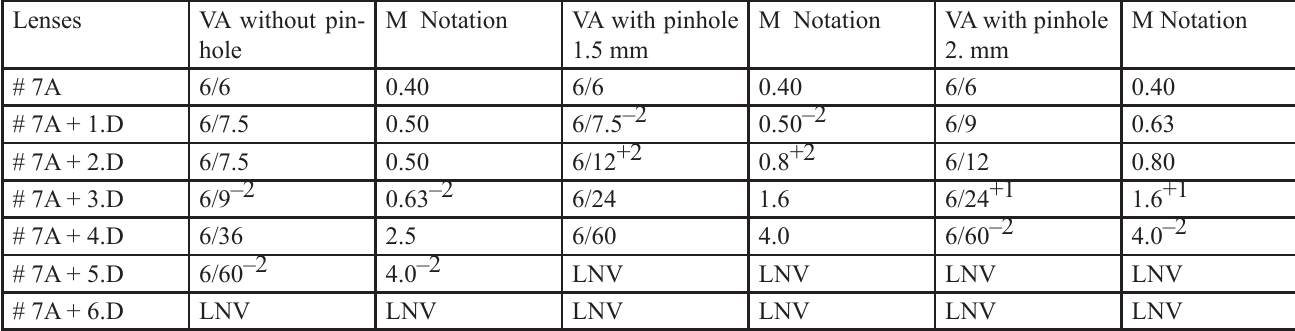
Table 3. Effect of positive lenses on VA for Subject 1 viewing a Lighthouse near acuity chart at 40 cm without a pinhole and through a pinhole with a 1.5 mm and 2 mm diameter respectively while the target was illuminated at 1 lux.